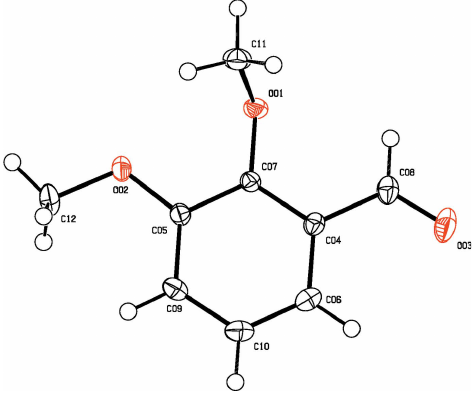
Figure 1 The molecular structure of 2,3-DMBz, showing displacement ellipsoids drawn at the 50% probability level.